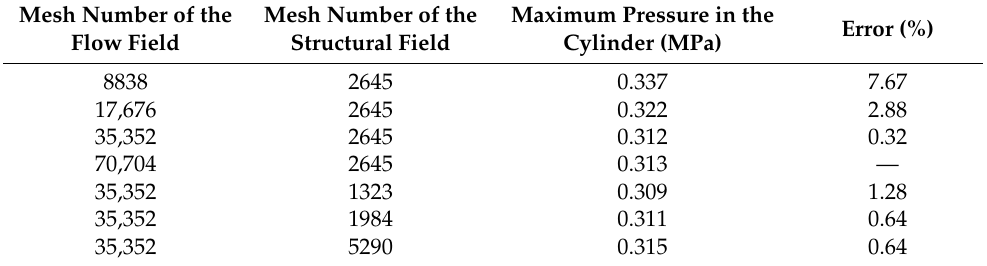
Table 3. Verification of grid independence.